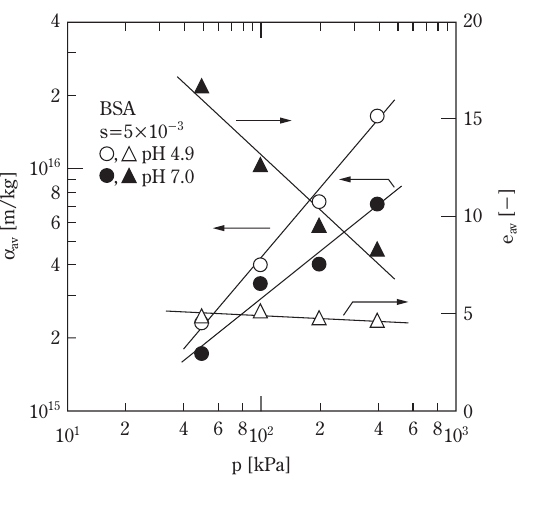
Fig. 7 Distributions of local specific filtration resistance in filter cake for different filtrate